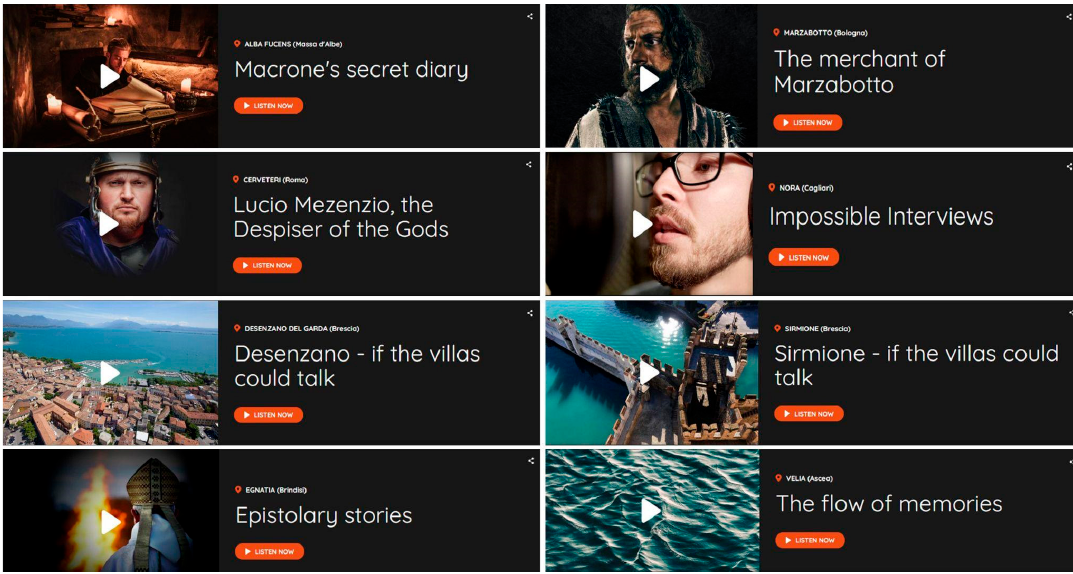
Figure 12. e-Archeo Voices: the eight topics of the podcast (by Lo